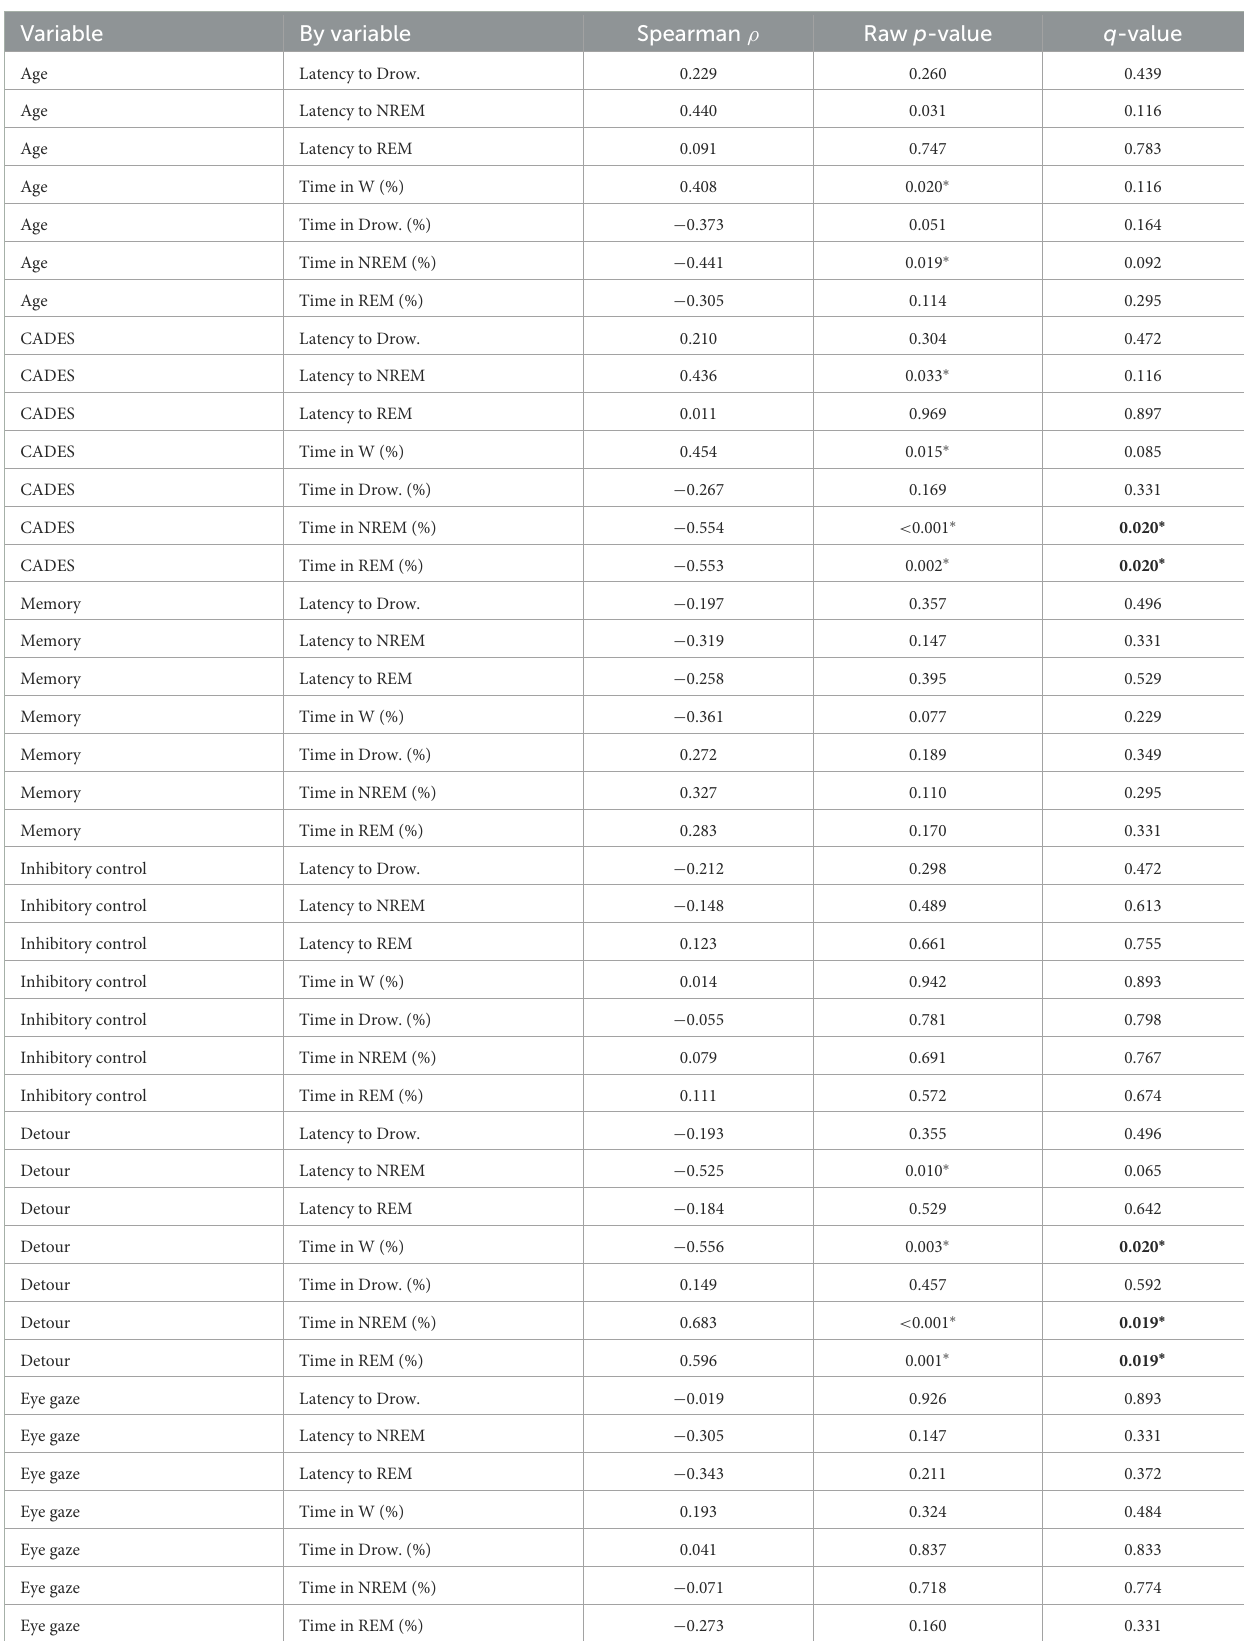
TABLE 1 Correlation between sleep macrostructure and age and cognitive function.